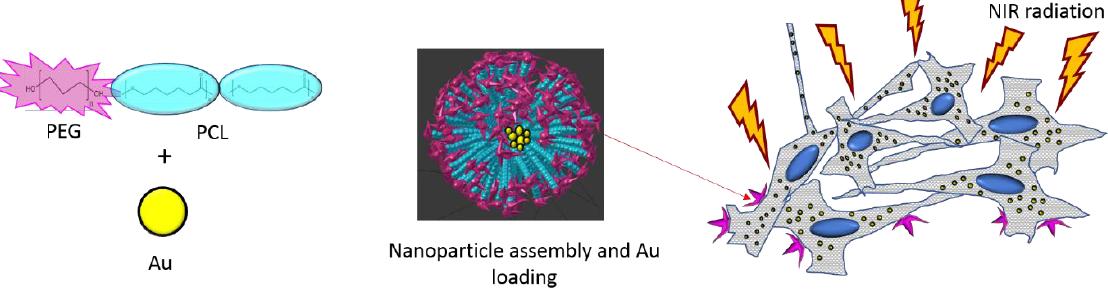
Figure 3. Polyethylene glycol-polycaprolactone (PEGylated-PCL) micelle loaded with gold nanoparticles to induce apoptosis into NIH3T3 cancer cells in vitro, when stimulated by near infrared radiation (NIR). Freely adapted from Shagan et al. 2018